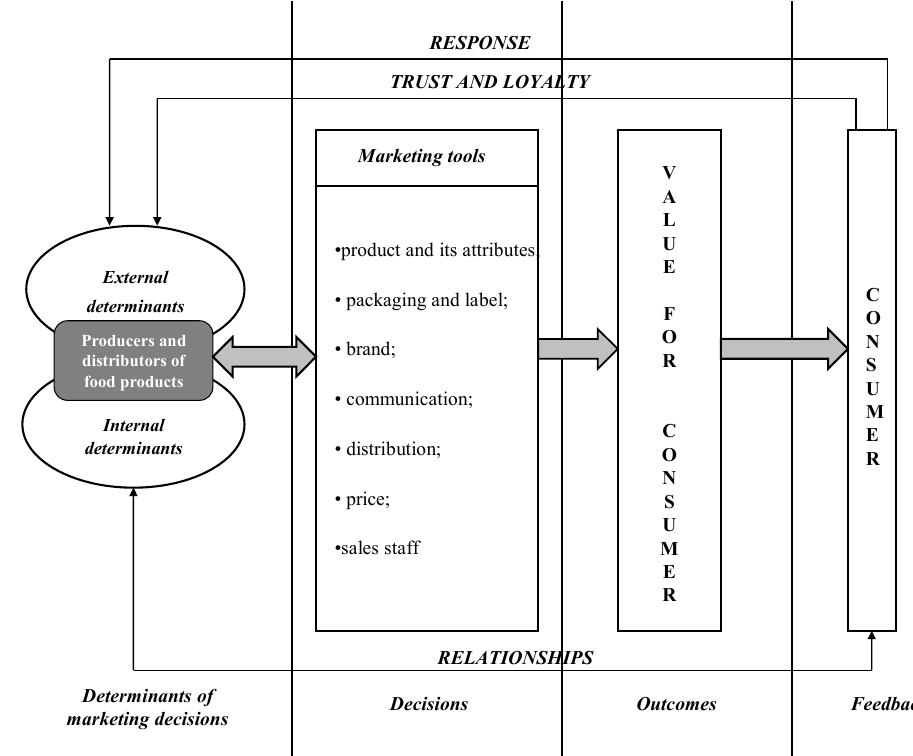
Figure 1. Building consumer satisfaction in the food market. Source: based on own research.